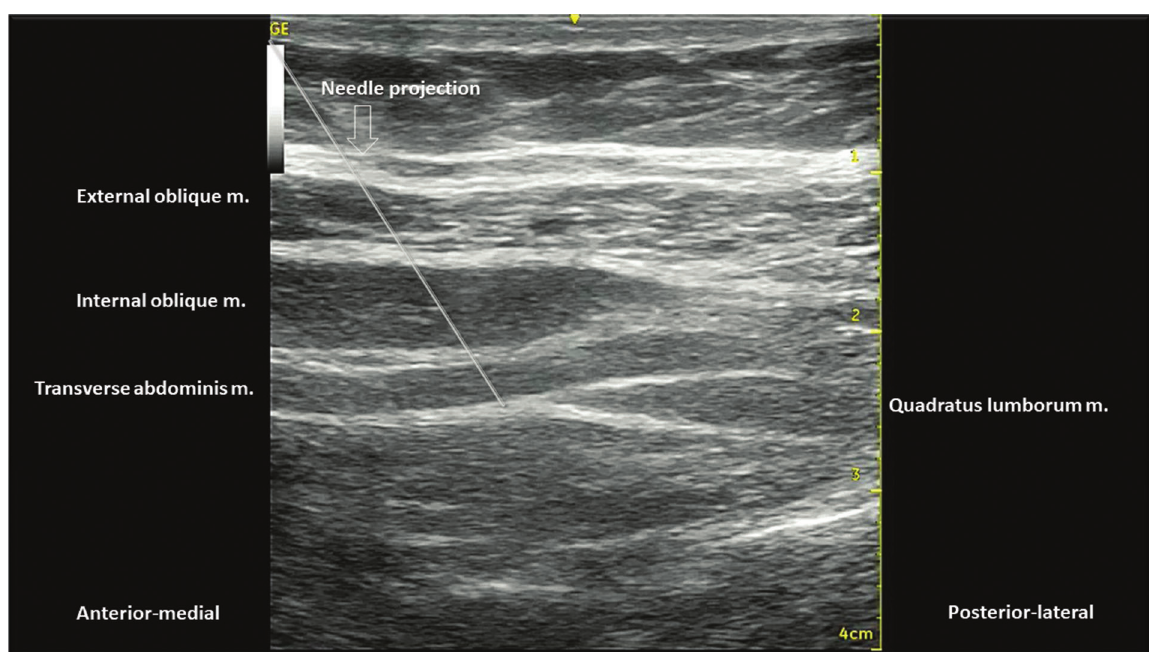
Figure 16 - US image with needle position projection. The tip is located deeper than the TA muscle, laterally to the lateral border of the QL muscle.